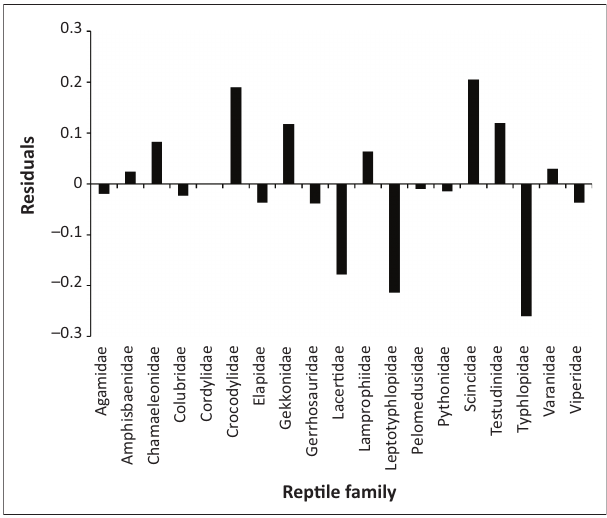
FIGURE 1: Linear regression residuals demonstrating coverage biases across reptile families within the Kruger National Park. Families with positive residuals occur more frequently than expected based on family-level species richness, although families with negative residuals are considered under-sampled.